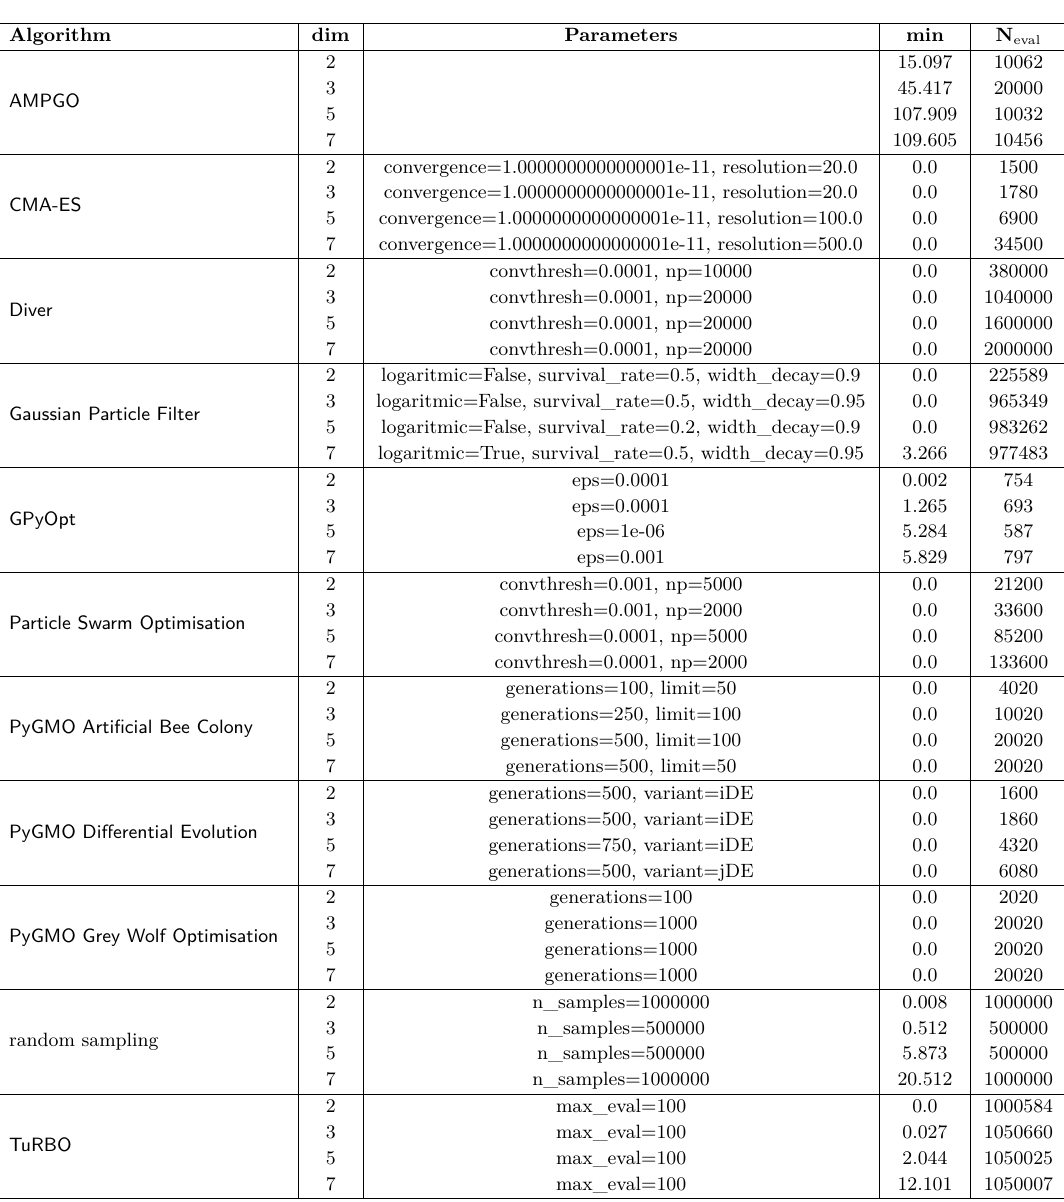
Table 4. Best obtained result for Analytic Function 2 (equation (3.2)). The ‘best’ result is the result with the lowest found function value. If multiple samples found the same value, the result with the fewest number of needed function evaluations is